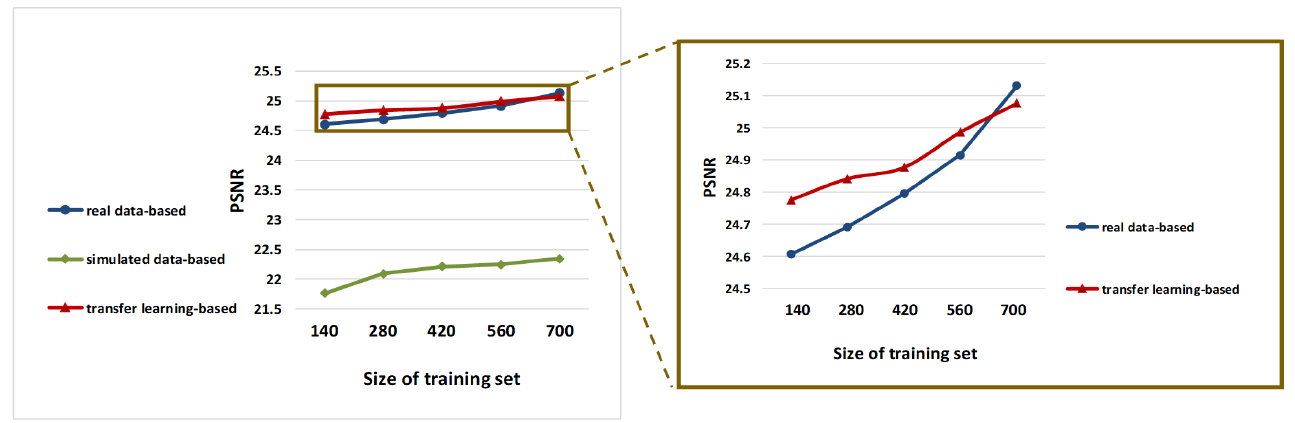
Figure 12. The trend of the PSNR values with increasing training